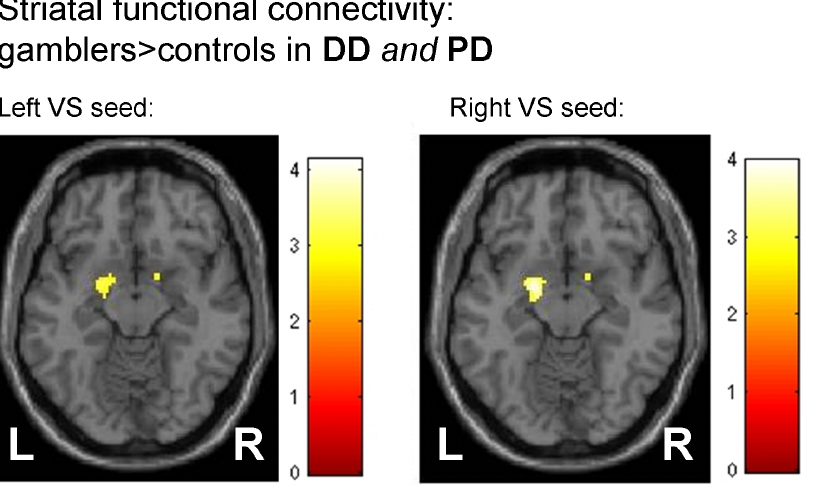
Figure 2. Regions showing greater striatal functional connectivity in gamblers vs. controls, conjunction analysis across delay and probability discounting trials (display threshold p , 0.005 uncorrected for each contrast, p svc , .05 for left amygdala). Color bars denote t-values.